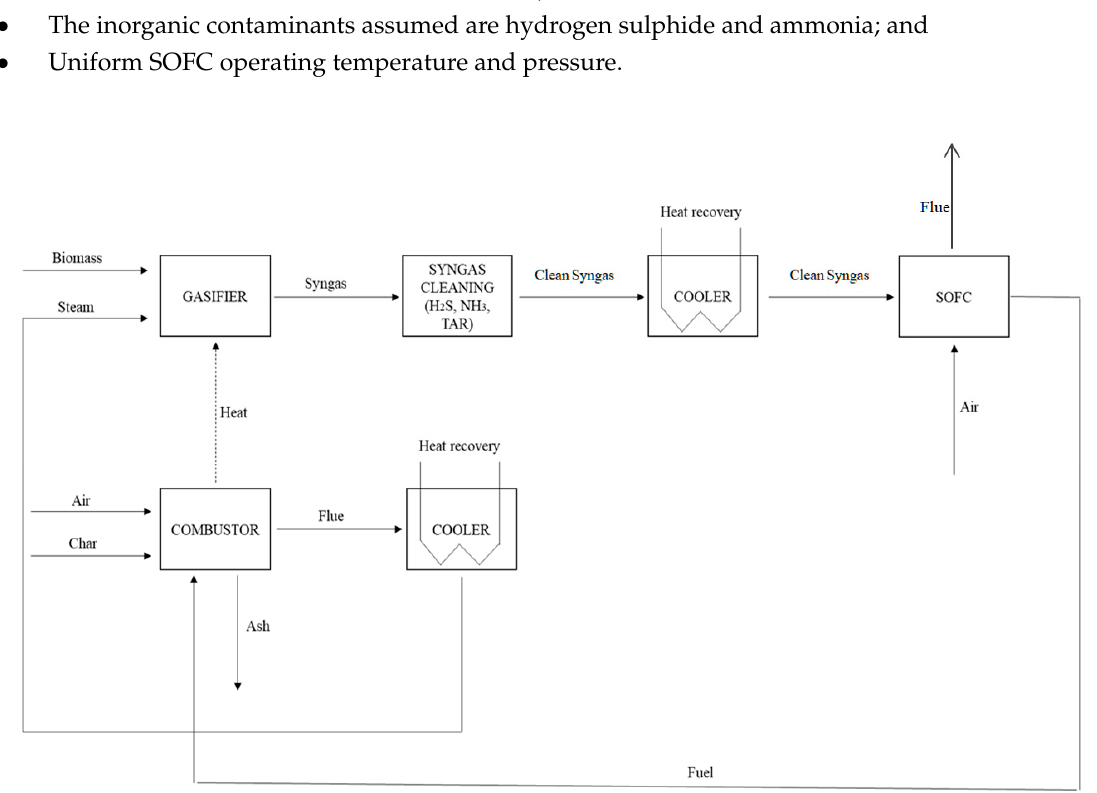
Figure 1. Simplified block diagram of biomass gasification, syngas cleaning, and the SOFC system.